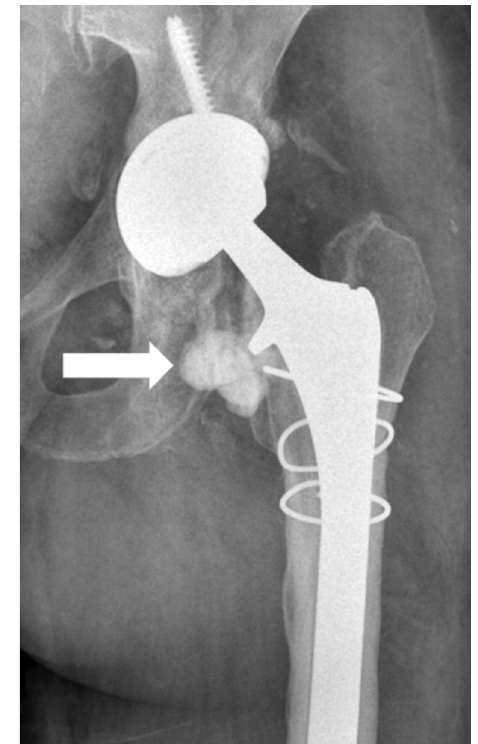
Radiograph after revision (fractured ceramic liner away Fig. 3: from joint indicated by